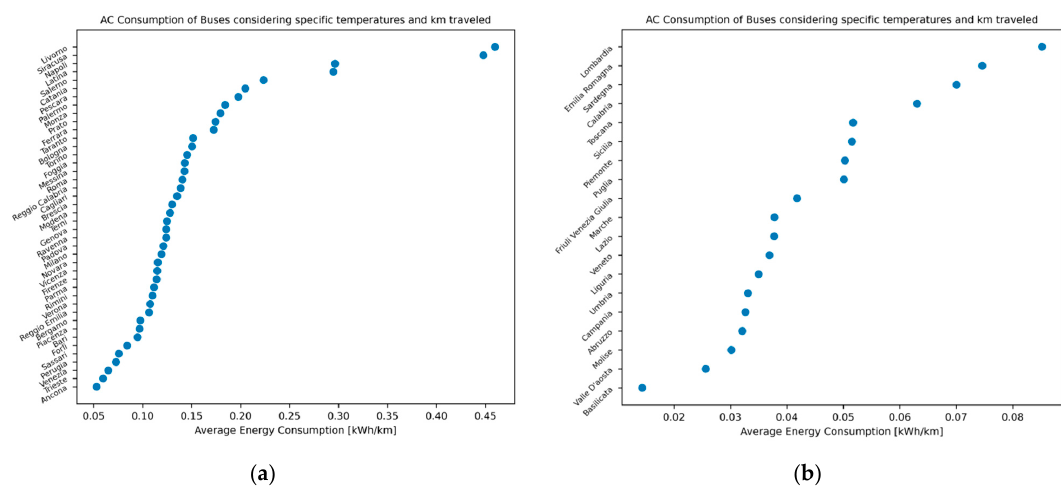
Figure 11. Specific air conditioning consumption of standard electric buses for the Italian cities with a population larger than 100,000 inhabitants (left panel) and regions (right panel).